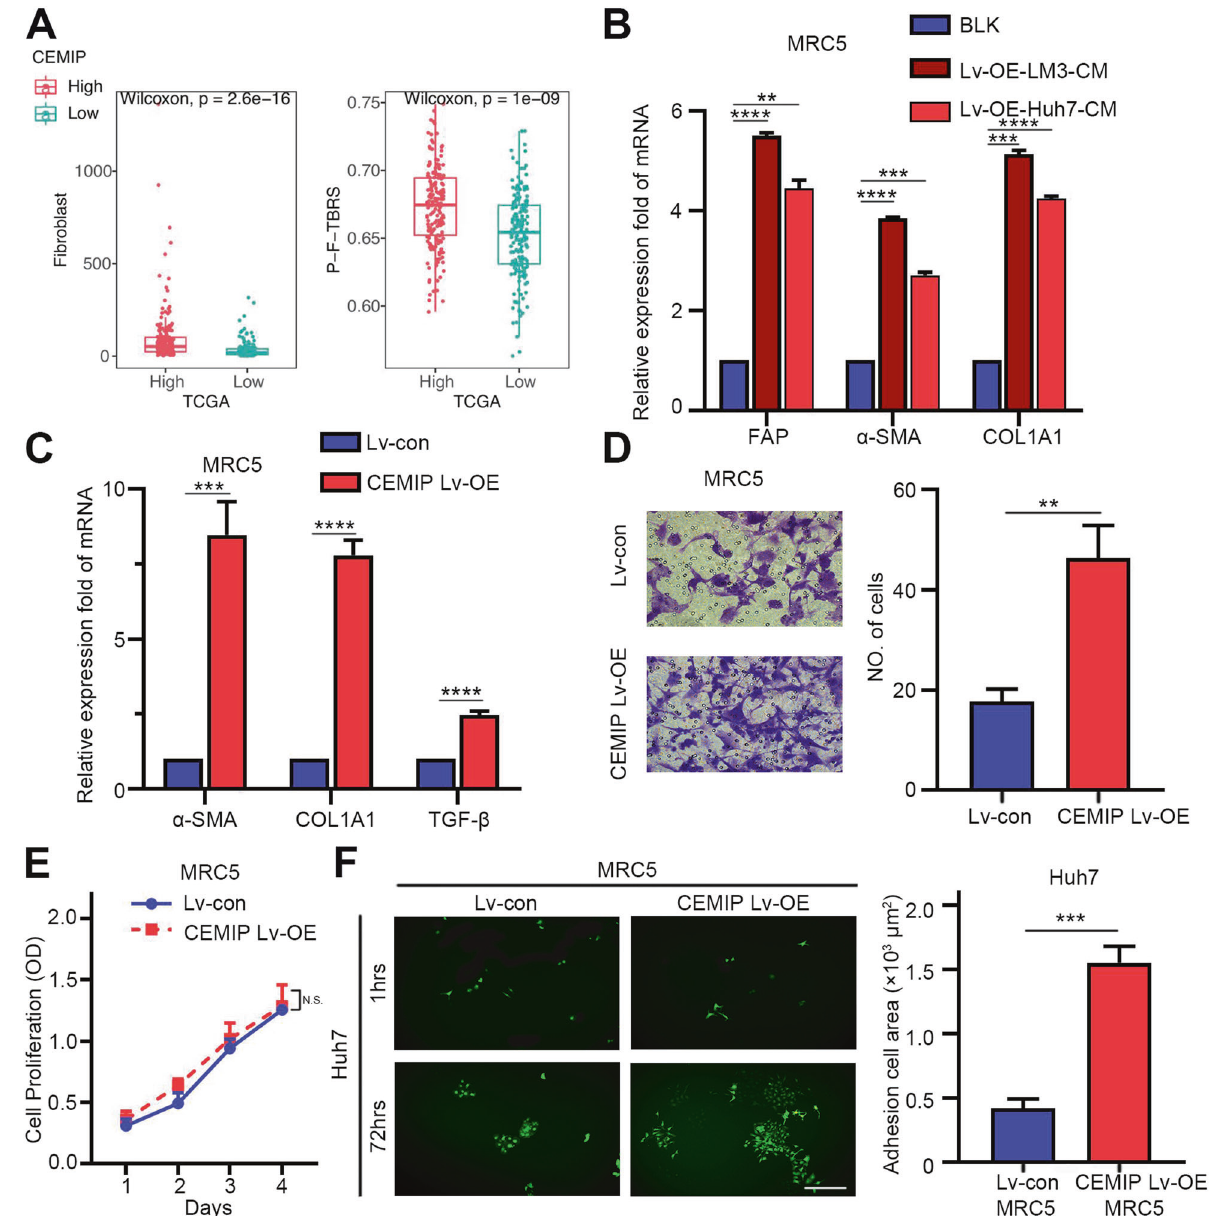
Fig. 3 CEMIP regulates lung fi broblast activation to promote liver cancer progression. A The association between CEMIP and fi broblasts. A comparison of the extent of fi broblast in fi ltration in the tumor microenvironment between tumors exhibiting high and low levels of CEMIP expression (left panel). A comparison of the pan- fi broblast TGF-beta signature scores between tumors exhibiting high and low levels of CEMIP expression (right panel). B Indicated fi broblast marker expression levels in MRC5 cells treated with CM from CEMIP-overexpressing lentivirus- transfected HCC cells were detected by qRT-PCR analysis. C The expression levels of α -SMA, COL1A1, and TGF- β in MRC5 cells treated with the CEMIP-overexpressing lentivirus or blank control were detected by qRT-PCR analysis. D Migration assays of MRC5 cells treated with the CEMIP- overexpressing lentivirus or blank control. Migrated cells were counted, and representative images are shown. E MRC5 cells were stably infected with the empty vector or CEMIP-overexpressing lentivirus and cultured for 1 – 4 days. Cell proliferation was detected by the Cell Counting Kit-8 (CCK-8) assay. F Images and quanti fi cation of adhesion and proliferation of Huh7-GFP cells (green) on LFs (MRC5) treated with the CEMIP-overexpressing lentivirus or blank control. Scale bar = 100 μ m. ECM stiffness and modulates tissue remodeling marker MMPs [30 – 33]. Here, we proved that CEMIP-mediated matrix stiffness could promote the secretion of autocrine TGF- β 1 from LFs (Supplementary Fig. S3A). Next, in the in vivo nude mouse orthotopic transplantation model, proteins were extracted from lung tissues. Western blot analysis showed an enhanced expres- sion of CEMIP, MMP7, MMP9, and TGF- β 1 in individuals with lung metastasis compared to those without lung metastases (Fig. 5A).